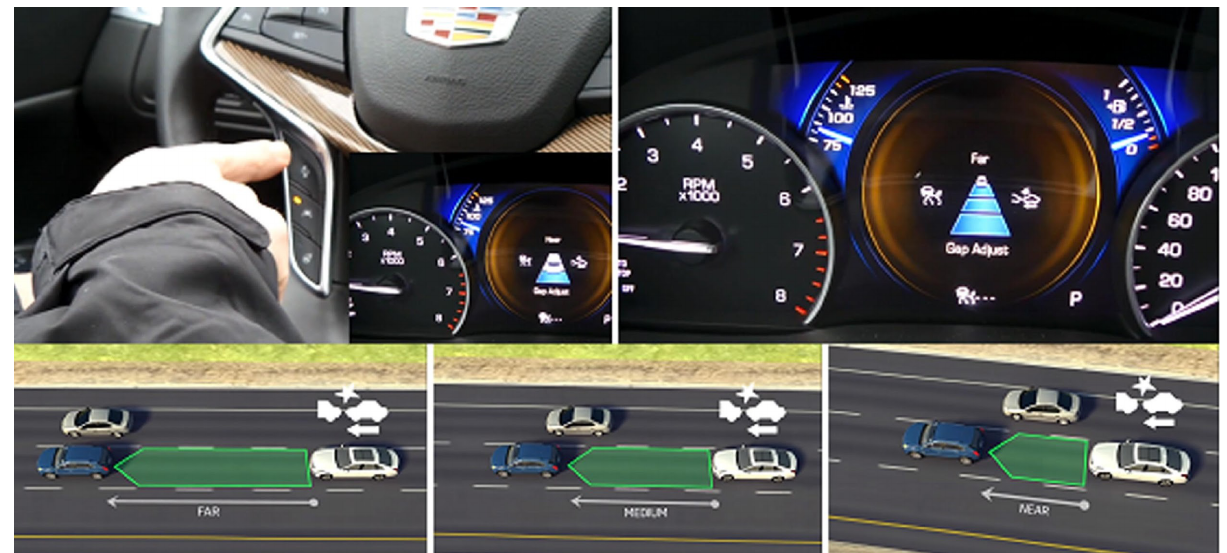
Figure 2: Diagram of keeping a distance behind the vehicle ahead using ACC [8]